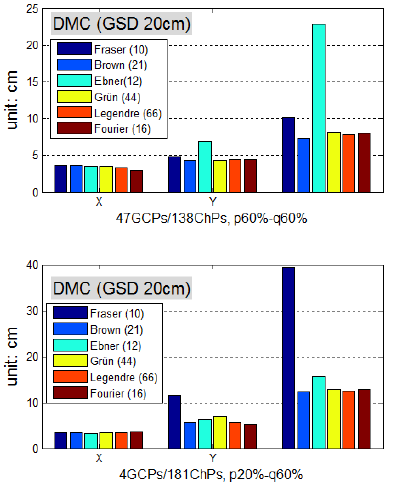
Fig. 3 Accuracy comparison of different APs in two blocks: the in-situ block (above) and the operational block (below)